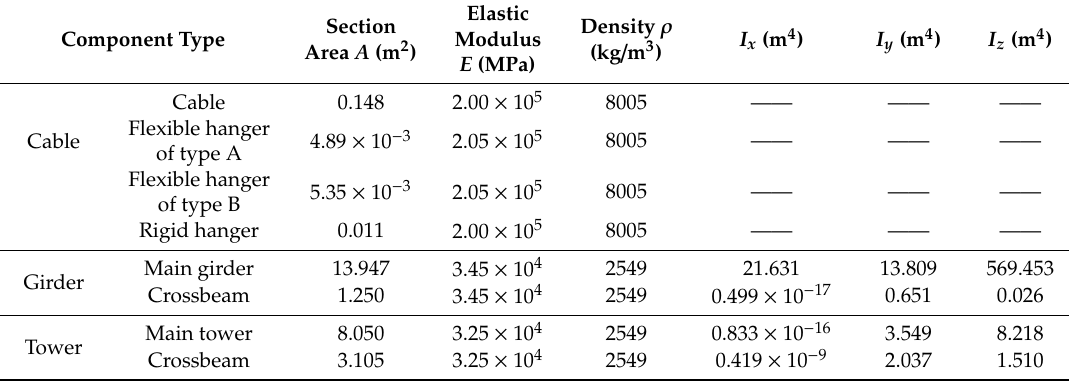
Table 1. Typical cross-sectional properties and material parameters of the Hunan Road Bridge.